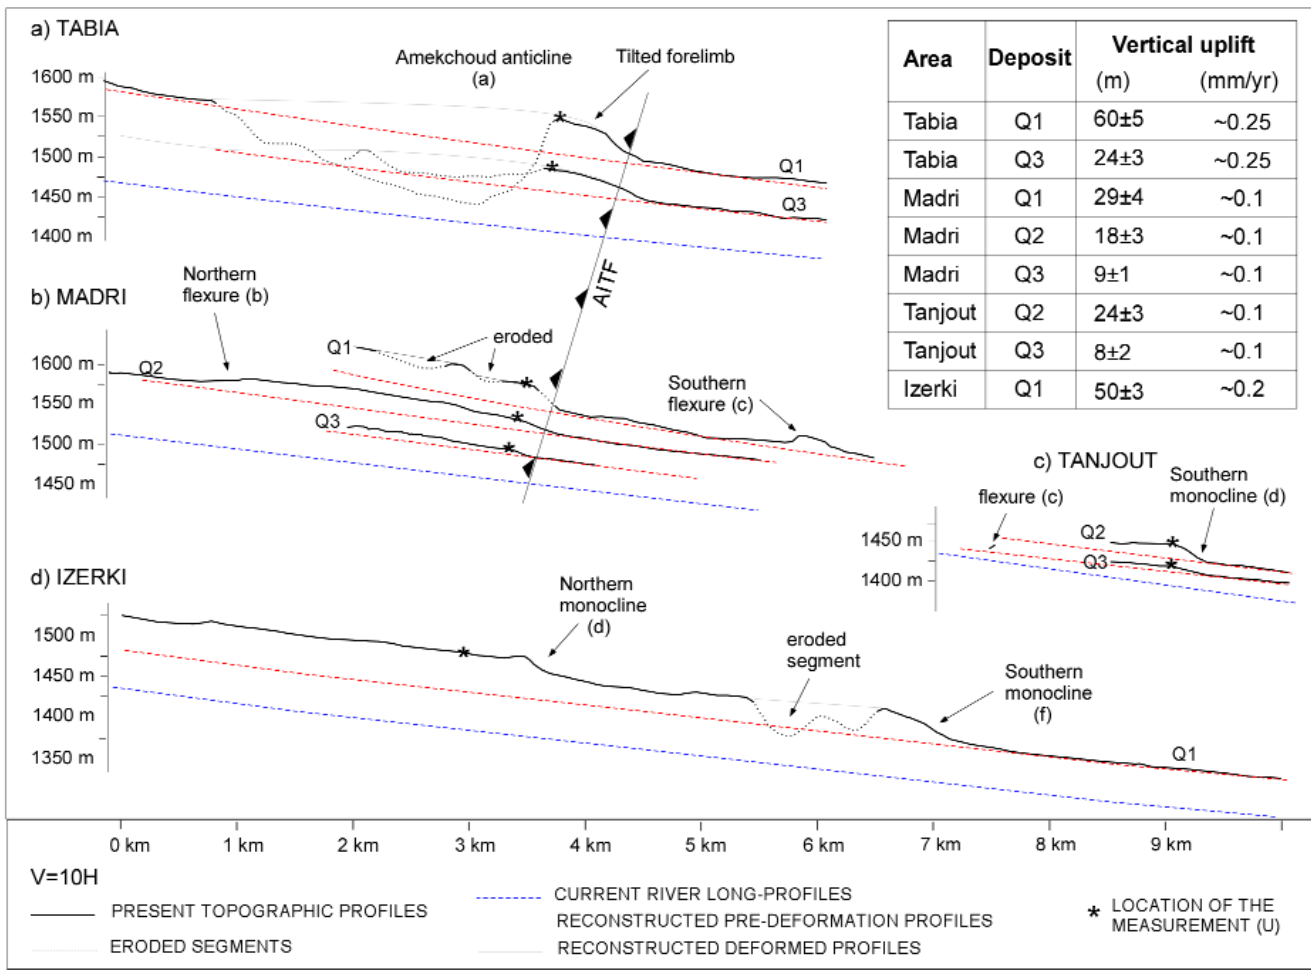
Figure 6. Topographic profiles projected onto lines perpendicular to the structures for the Tabia, Madri, Tanjout and Izerki areas. The profiles are vertically exaggerated 10-fold. Red dashed lines represent the reconstructed pre-deformation profile for each terrace. The table indicates the structural uplift measured (U) for each terrace. The sites where terrace heights were measured are indicated in the